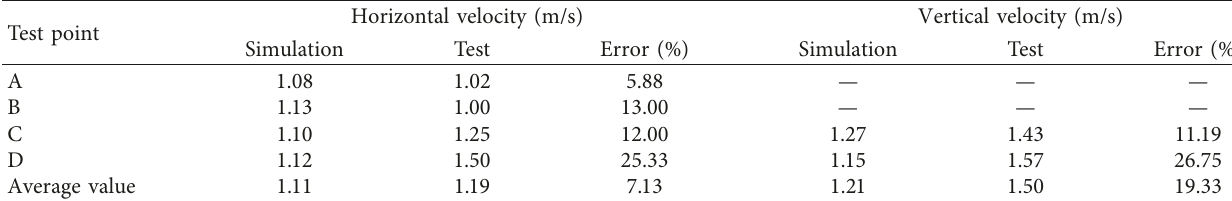
Figure 16: Comparison of the design spectrum of the test points. (a) Horizontal design spectrum at A. (b) Horizontal design spectrum at B. (c) Horizontal design spectrum at C. (d) Vertical design spectrum at C. (e) Horizontal design spectrum at D. (f) Vertical design spectrum at D. Table 3: Spectral velocity comparison of the platform.